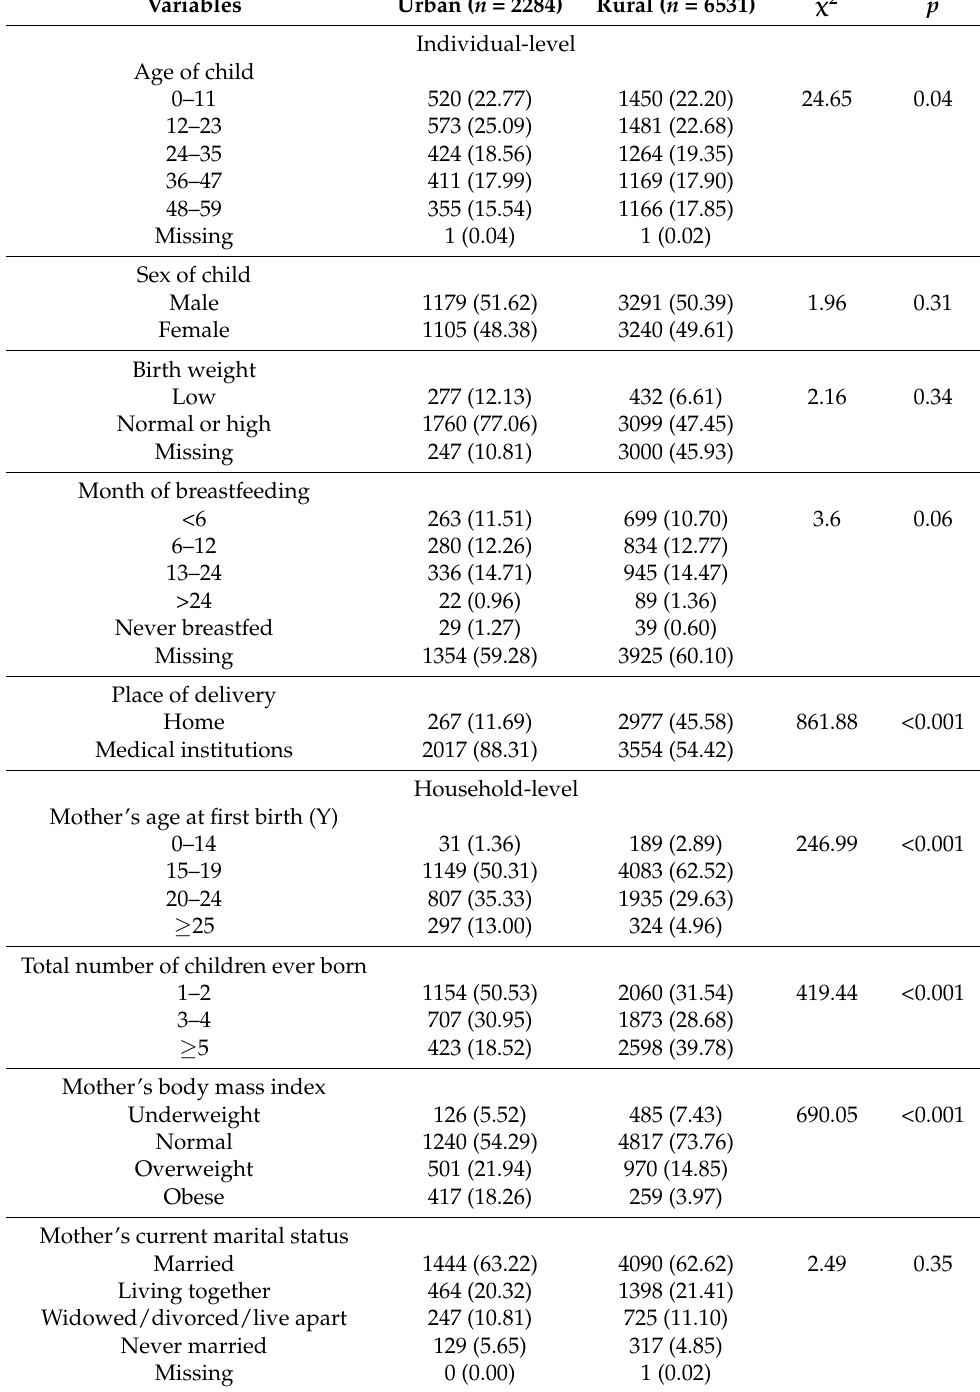
Table 1. Individual-level and household-level characteristics of under-5 children among rural and urban areas based on 2015–2016 Tanzania Demographic and Health Surveys (weighted frequency) ( n